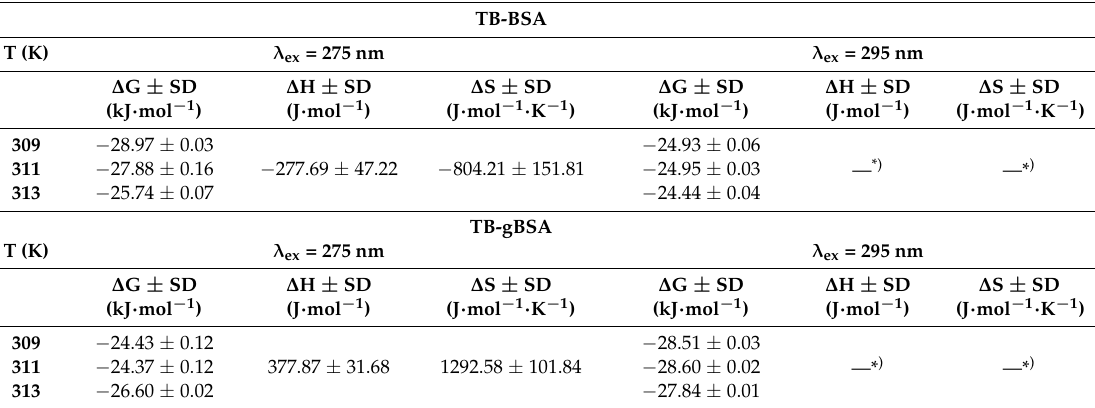
Table 4. The thermodynamic parameters of formation of the TB-BSA and TB-gBSA complex; λ ex = 275 nm and λ ex = 295